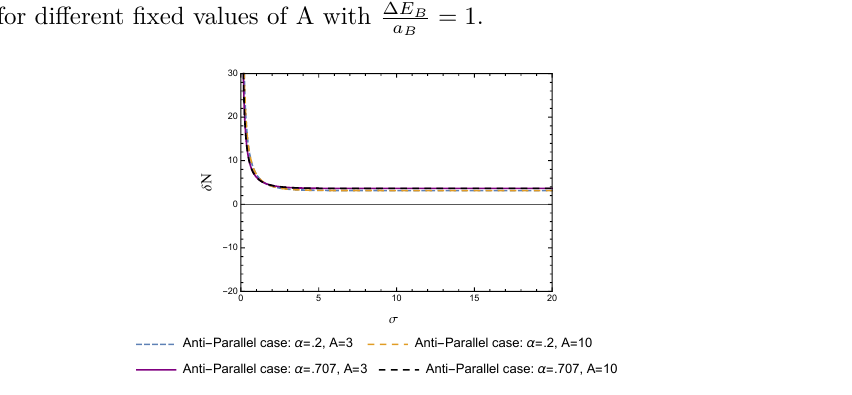
Figure 14 . Parallelly accelerating detectors in (1 + 1) dimensions with thermal background: δ N VS σ = β ∆ E plot for different fixed values of the coefficient α and A with ∆ E B